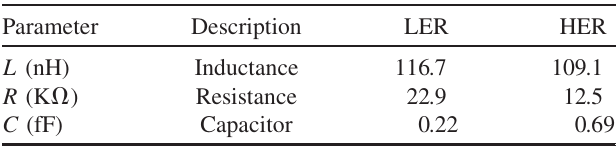
TABLE I. Parameters of the LRC impedance model for both rings.